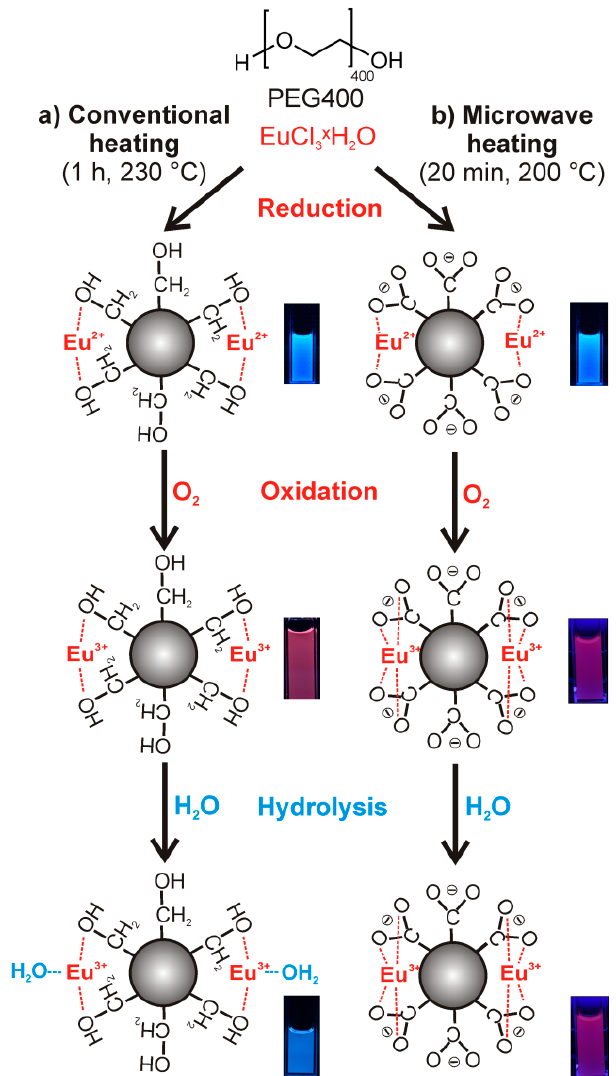
Figure 1. One-pot polyol synthesis of Eu-modified C-dots with the role of Eu 2+ , Eu 3+ , O 2 , H 2 O, and the influence of ( a ) conventional resistance heating and ( b ) MW-heating on the surface functionalization and PL (excitation via UV-LED, λ max = 365 nm, SI: Figure S2).